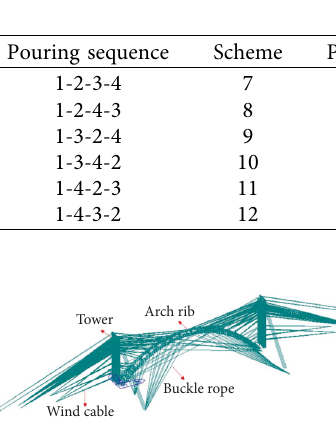
Figure 3: Finite element model of concrete pouring.